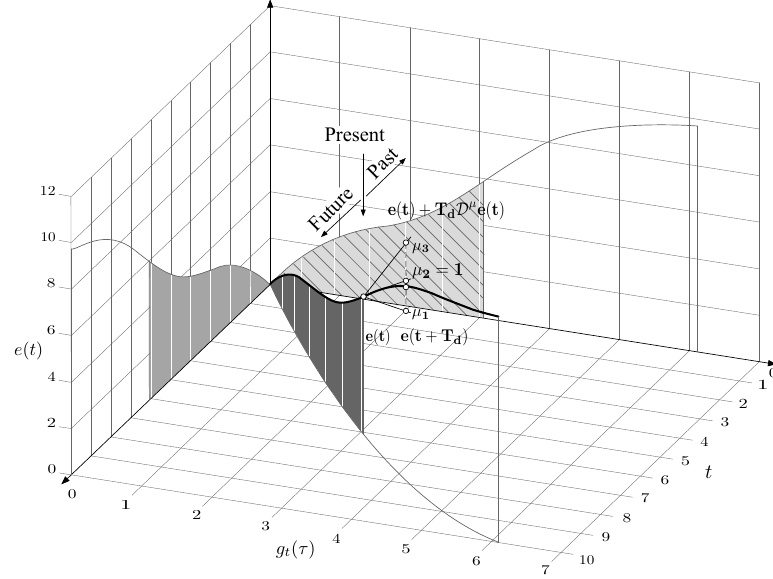
Figure 2. Evolution of the error (fractional PID